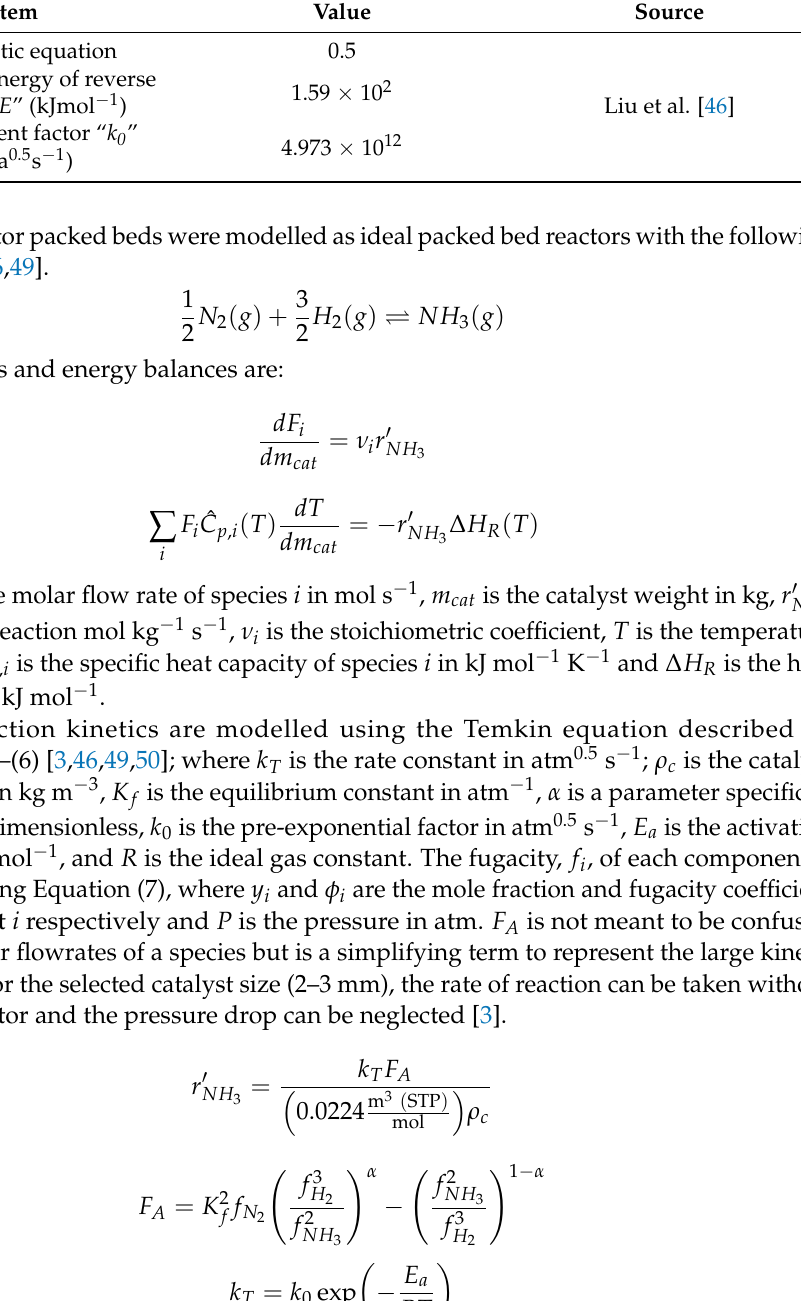
Table 1. Ammonia Synthesis Catalyst parameters.